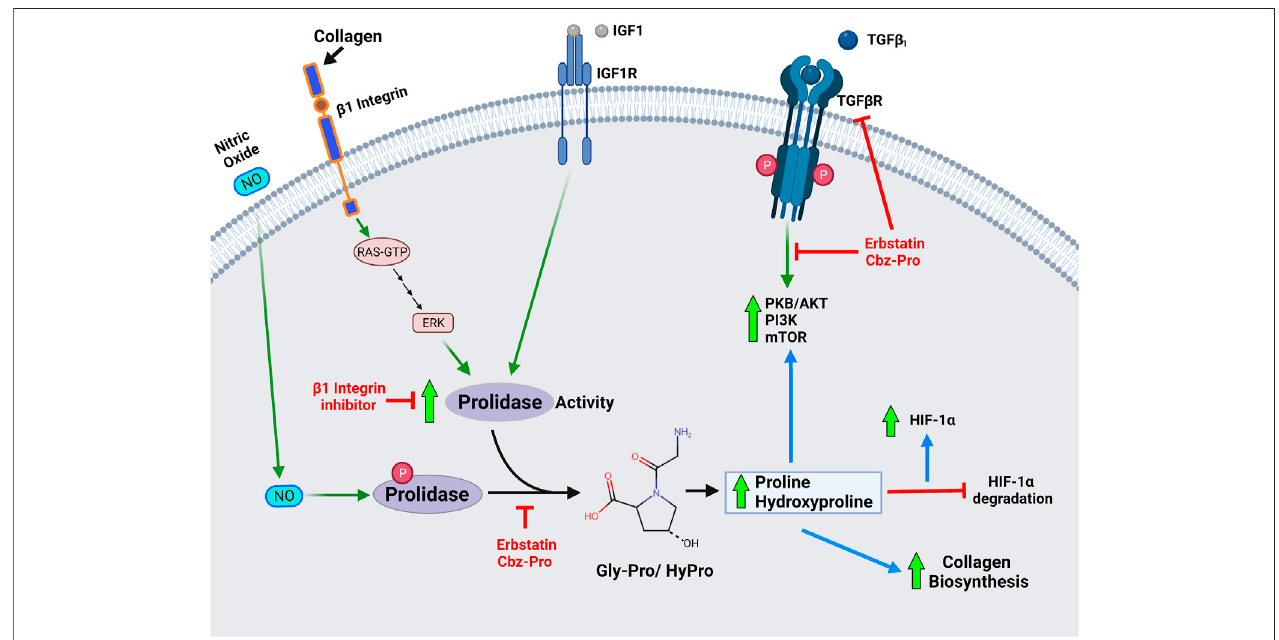
FIGURE3| Diagramdepictingroleofprolidaseenzymaticactivityincellular regulation-Prolidase playsapivotalroleincollagenmetabolism,matrixremodelingand cell growth. Therefore, prolidase, is essential in several physiological processes such as wound healing, in fl ammation, angiogenesis, cell proliferation, and carcinogenesis. Accordingly, primary mechanisms that are known to regulate prolidase activity include-activation of the β 1 integrin receptor, insulin-like growth factor 1 receptor (IGF-1R), and transforming growth factor (TGF) receptor. Stimulation of these receptors by their ligands-collagen, IGF1 and TGF β 1 respectively affect prolidase enzyme activity and downstream processes associated with cell proliferation and growth. Nitric oxide (NO) mediated phosphorylation of prolidase has been shown to increase enzyme activity, while inhibition of phosphorylation renders a less active prolidase enzyme. The products of prolidase activity-proline and hydroxyproline stimulate collagen biosynthesis, stabilize HIF-1 α by inhibiting its degradation and induce TGF receptor mediated